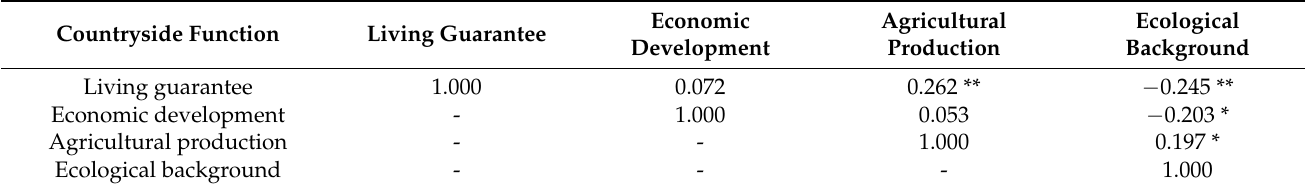
Table 2. Countryside functional correlation